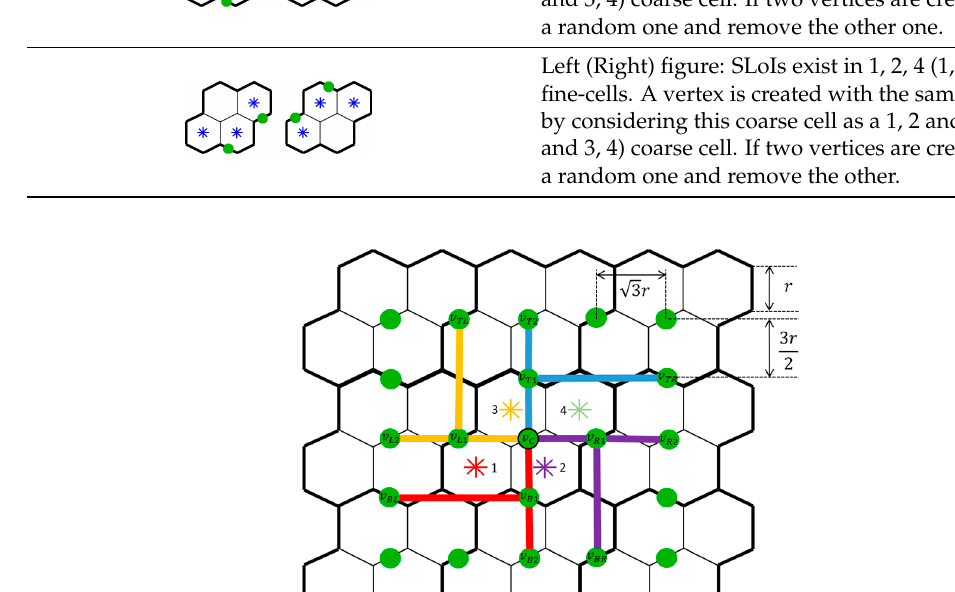
Figure 3. Possible MST vertices and edges surrounding a coarse cell. Algorithm 1: clockwiseCircumnavigationPathGeneration Input : (cid:1845), (cid:1846) (cid:3040)(cid:3036)(cid:3041) = ((cid:1848) (cid:3021) , (cid:1831) (cid:3021) ), (cid:1871)(cid:1868) (cid:2869) ∈ (cid:1845) Output : (cid:1868) = ((cid:1871)(cid:1868) (cid:2869) , … , (cid:1871)(cid:1868) (cid:3050) ), (cid:1871)(cid:1868) ∈ (cid:1845) 1 (cid:1874) (cid:3030)(cid:3048)(cid:3045)(cid:3045)(cid:3032)(cid:3041)(cid:3047) = (cid:1871)(cid:1868) (cid:2869) ; 2 do 3